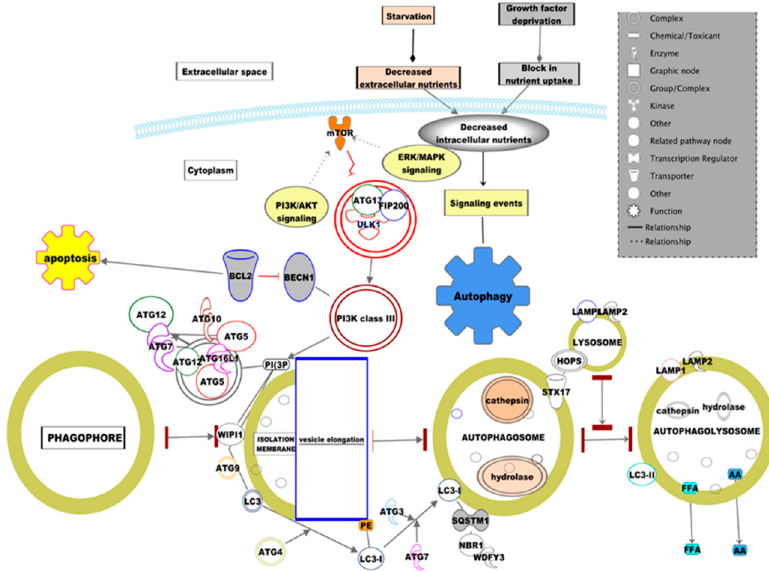
Figure 1. The autophagy-A highly conservative cascaded regulatory mechanism upholds the intracellular homeostasis of the biological system. Five steps are involved in the autophagy signaling cascades: 1. Nucleation of the phagophore; 2. expansion of the phagophore; 3. formation of the autophagosome; 4. fusion of the autophagosome–lysosome; and 5. degradation and efflux of the cargos are illustrated in the pathway. Using a build tool in the pathway developer of IPA (Ingenuity Pathway Analysis), the Autophagy–Canonical pathway was developed.